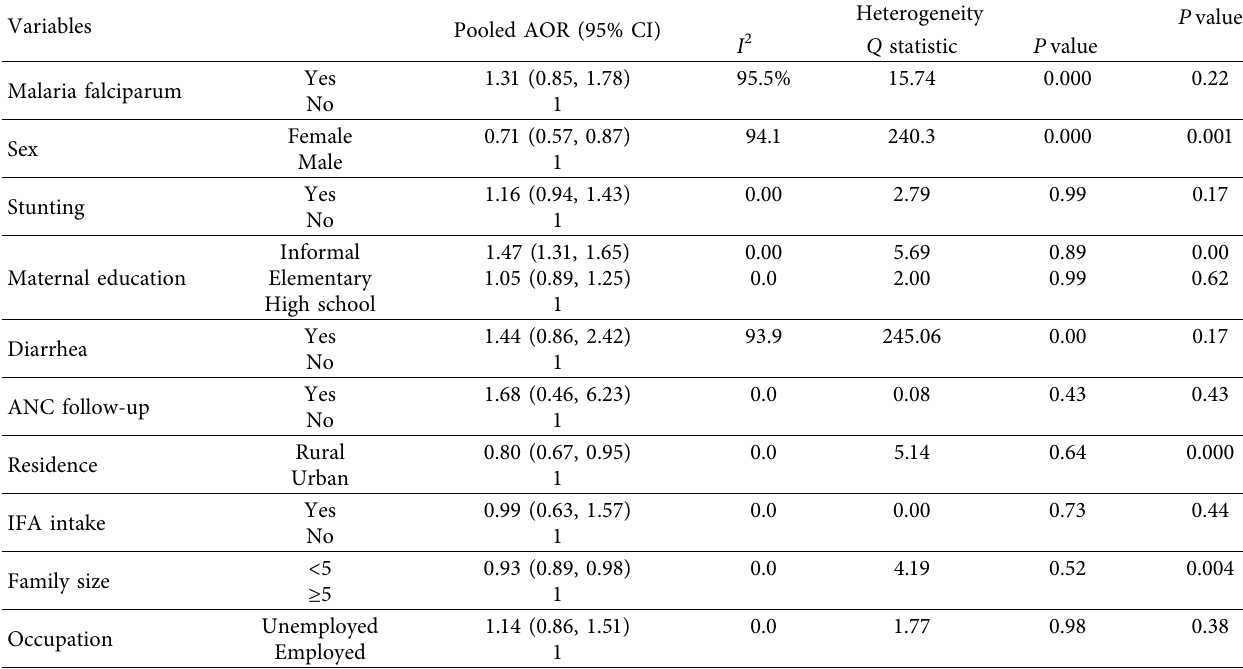
Table 2: Pooled determinants of anemia among under-five children in Africa,